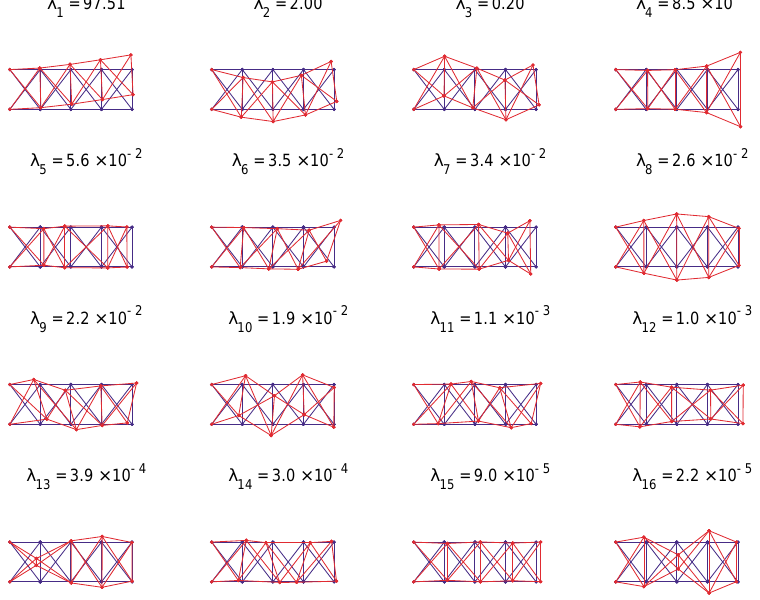
Fig. 4. Proper orthogonal modes with respective mean energies for vertical impulsive force applied at node 10.